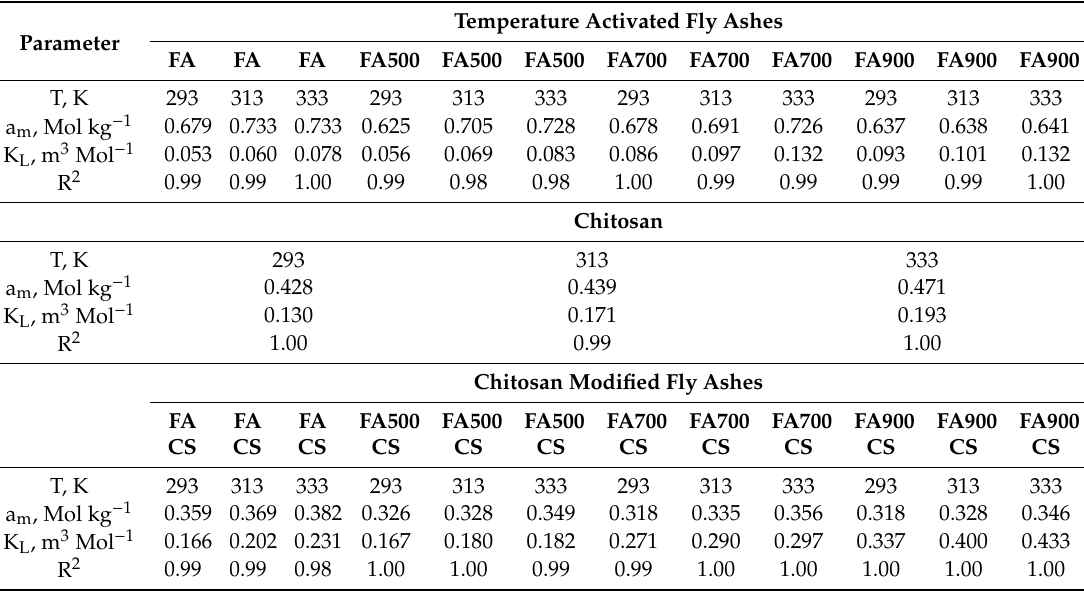
Table 5. Langmuir adsorption parameters for As(V) adsorption on the studied adsorbents. Abbreviations: a m —adsorption capacity, K L —equilibrium constant, R 2 —correlation coe ffi cient of experimental points fit to the linear form of the Langmuir equation.